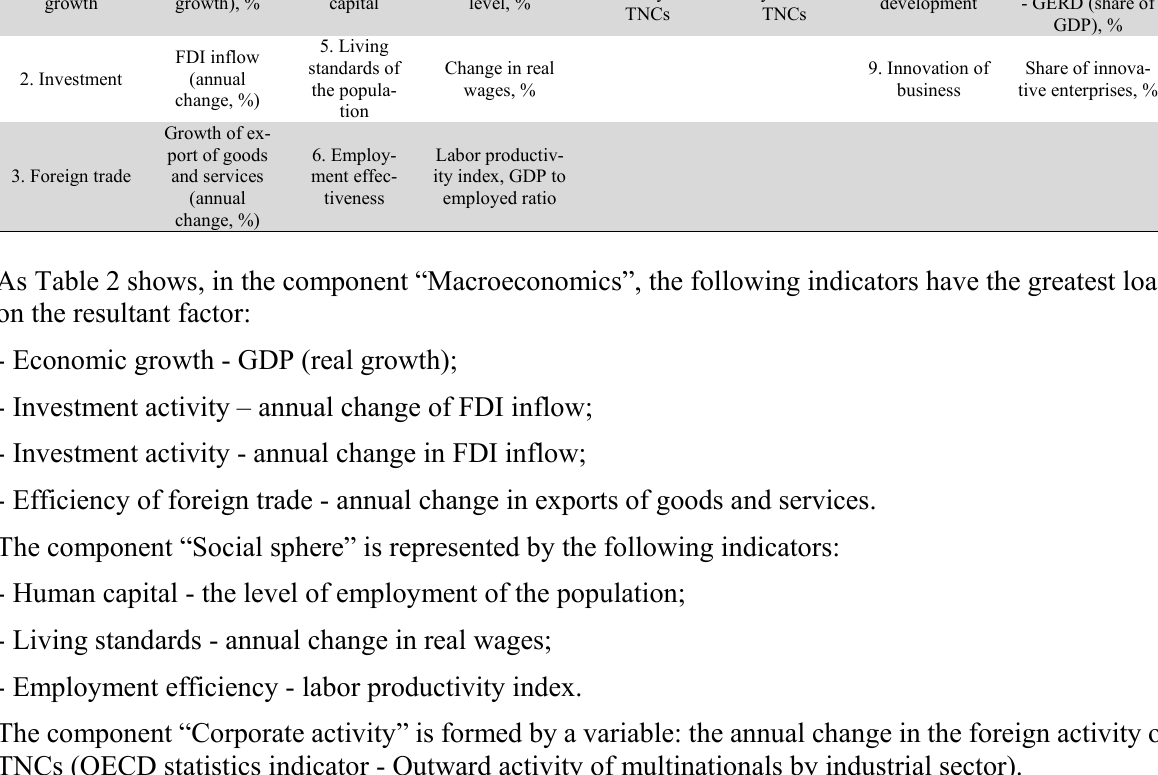
Factors affecting the national brand Macroeconomic component Factor 1 Factor Indicator Factor Indicator Factor Indicator Factor